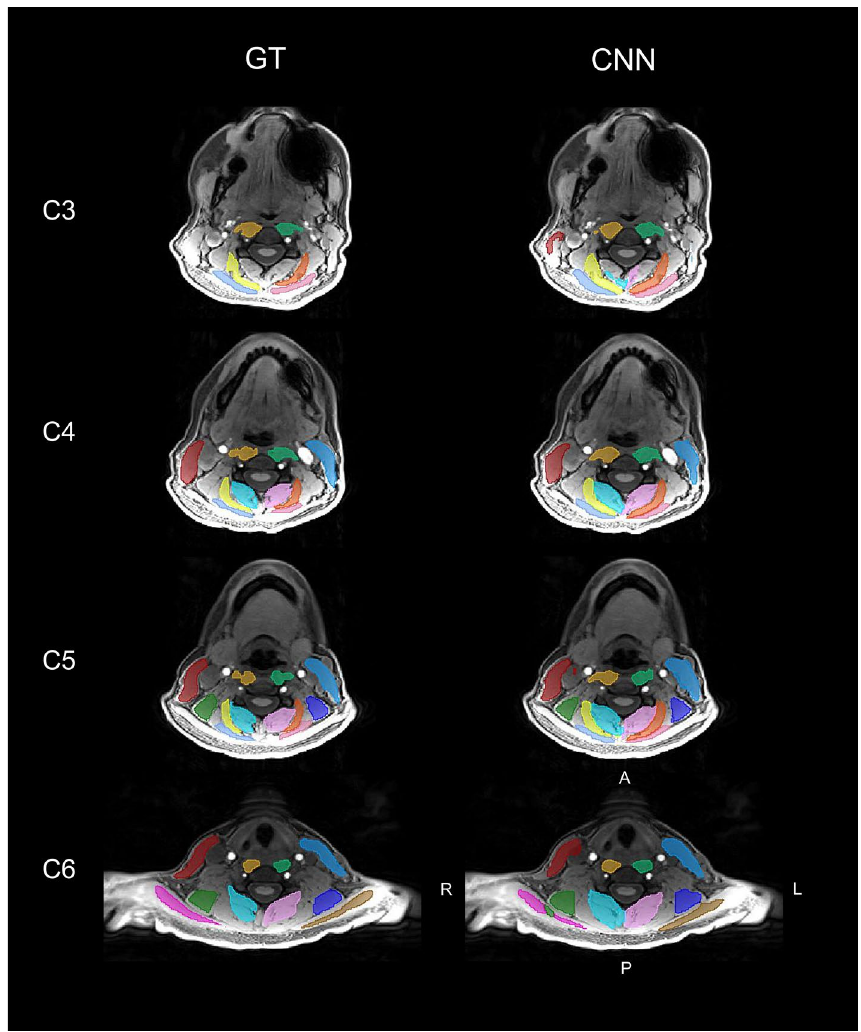
Figure 1. Multi-muscle convolutional neural network (CNN) segmentation of seven cervical spine muscle groups. CNN segmentation masks for the ground truth (GT) and CNN from a randomly selected testing scan are shown overlaid the water-only image. Axial images at the C3–C6 vertebral levels were selected to show changes in muscle morphometry across the cervical spine. The muscle groups segmented included the MFSS (left = light pink, right = aqua), LC (left = light green, right = gold), SSCap (left = orange, right = yellow), SPCap (left = dark pink, right = light blue), LS (left = indigo, right = dark green), SCM (left = blue, right = red), and TR (left = brown, right = magenta). The artifact in the left jaw is due to metal from dental work. See Fig. 2 for three- dimensional renderings of the GT and CNN segmentations. L = left, R = right, A = anterior, P =